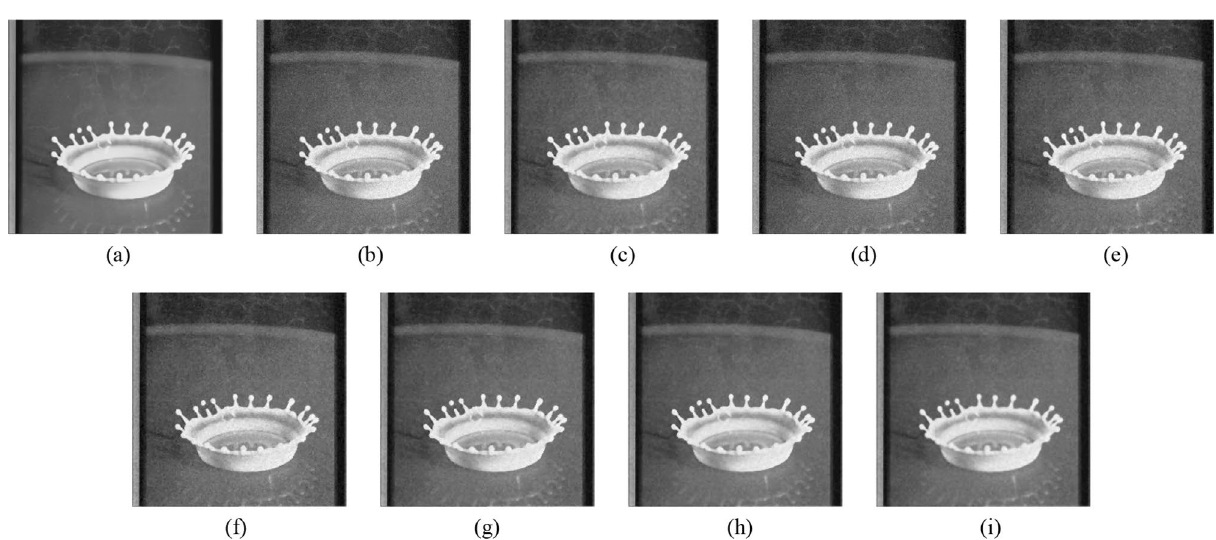
Figure 22. Comparison of denoising performance of each filter against the Gaussian noise (“Geometric pattern”). ( a ) Original image; ( b ) noise-added image; ( c ) filtered image using abwFMGFI; ( d ) filtered image using FMGFI (BW = 1 level); ( e ) filtered image using FMGFI (BW = 3 level); ( f ) filtered image using FMGFI (BW = 5 level); ( g ) filtered image using FMGFI (BW = 11 level); ( h ) filtered image using FMGFI (BW = 21 level); ( i ) filtered image using FMGFI (BW = 51 level).